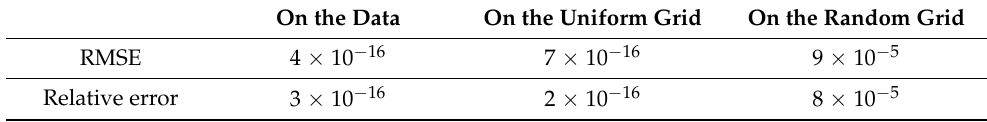
Table 2. Results furnished by COL in the first example. On the Data On the Uniform Grid On the Random